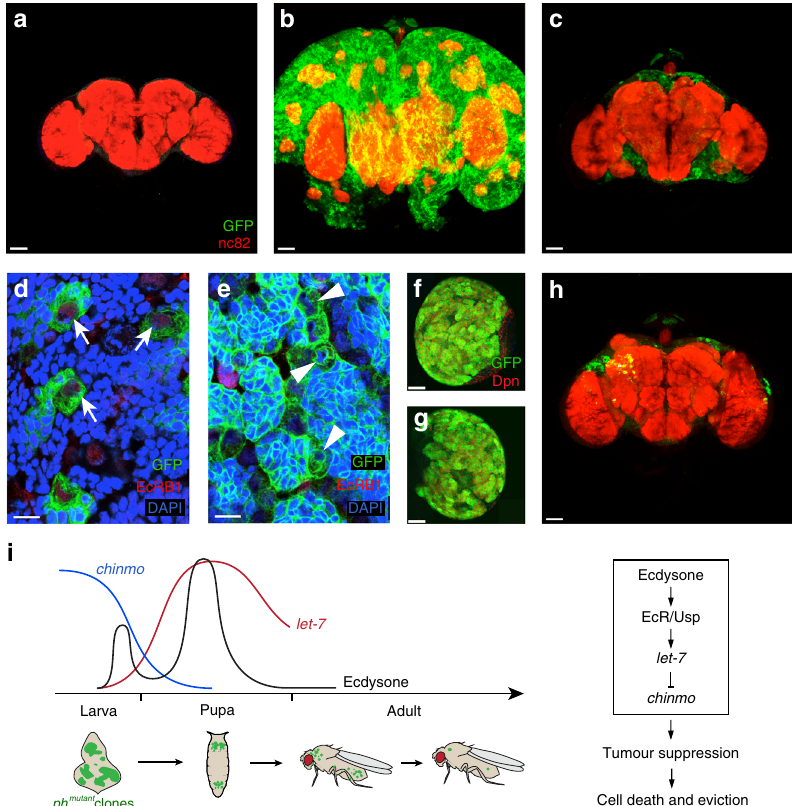
Fig. 4 Eviction of brat tumours in adult brains by expression of let-7 or ecdysone receptors. a − c Confocal images of adult brains of wild-type ( a ), UAS- RNAi-brat ( b ), and UAS-RNAi-brat; UAS-let-7 ( c ). The brains are stained with the nc82 antibody (red) revealing brain structures, and GFP (green) that is expressed in the brain tumour cells. Note that the number of tumour cells is clearly reduced and the growth of tumour is greatly suppressed in UAS-RNAi- brat; UAS-let-7 brains ( c ). Scale bars are 50 μ m. d , e Confocal images of third instar larval brains of wild-type ( d ) and UAS-RNAi-brat ( e ). EcRB1 is expressed weakly in the type II neuroblasts in wild-type brains ( d , arrows), but not in the tumour cells in UAS-RNAi-brat brains ( e , arrowheads). Cells strongly express EcRB1 in ( d ) and ( e ) are glia cells that are not labelled by GFP. Scale bars are 10 μ m. f Confocal image of a larval brain hemisphere of UAS-RNAi-brat , showing numerous tumour cells (green) that express Deadpan (Dpn) (red). Scale bar is 50 μ m. g Confocal image of a larval brain hemisphere of UAS- RNAi-brat; UAS-EcRB1 ; note that a large tumour still forms. Scale bar is 50 μ m. h Confocal image of an adult brain of UAS-RNAi-brat; UAS-EcRB1 ; note that the number of green brain tumour cells is signi fi cantly reduced. Scale bar is 50 μ m. i Model for the intrinsic tumour eviction mechanism mediated by ecdysone-induced miRNA let-7 in ph 505 tumours. In the drawing, ecdysone refers to 20-HE titres during prepupal and pupal stages 11[,12 ; chinmo and let-7 refer to the mRNA expression in the eye-antenna discs. Genotypes: a , d w UAS-dicer2; wor-Gal4 ase-Gal80; UAS-mCD8::GFP ; b , e , f w UAS-dicer2; wor-Gal4 ase-Gal80/UAS-RNAi-brat; UAS-mCD8::GFP/ + ; c w UAS-dicer2 ; wor-Gal4 ase-Gal80/UAS-RNAi-brat; UAS-mCD8::GFP/UAS-let-7 ; g , h w UAS-dicer2 ; wor- Gal4 ase-Gal80/UAS-RNAi-brat;